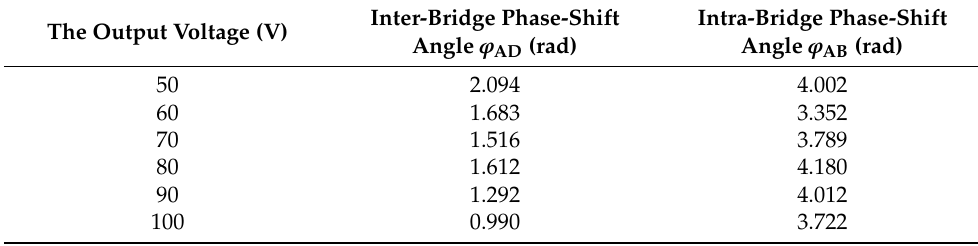
Table 3. Optimal combination of phase-shift angle at 200 W output power and 50–100 V output voltage. The Output Voltage